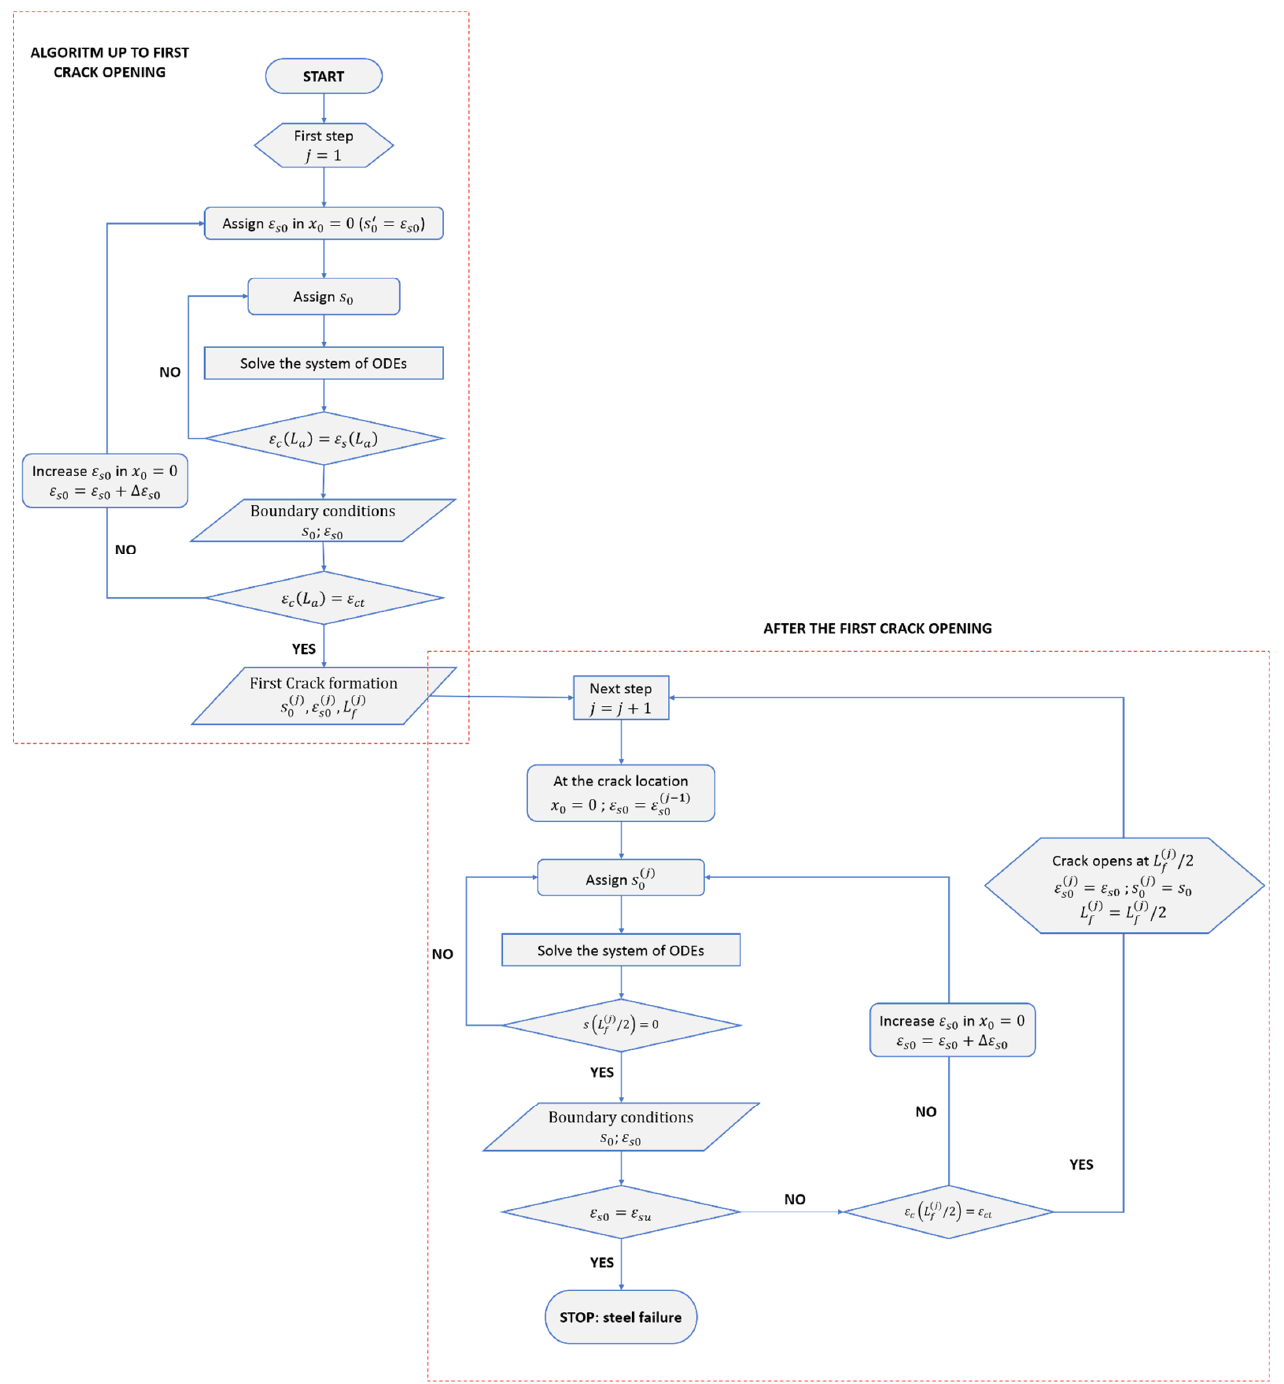
Figure 2. Flowchart of the numerical procedure to solve the bond–slip problem in r.c. elements.